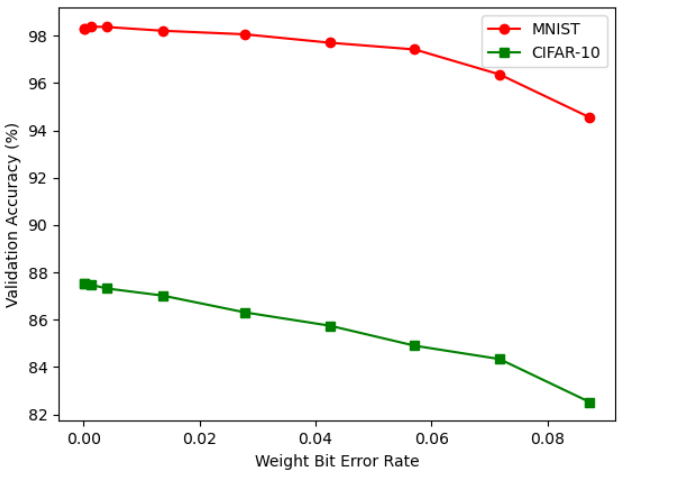
Figure 11. Weight bit error rate for the validation accuracy for the MNIST and CIFAR-10 databases. The RoC curves for the MNIST and CIFAR are shown in Figures 12–14. They show the FPGA for the CNN, followed by the BNN and QNN,